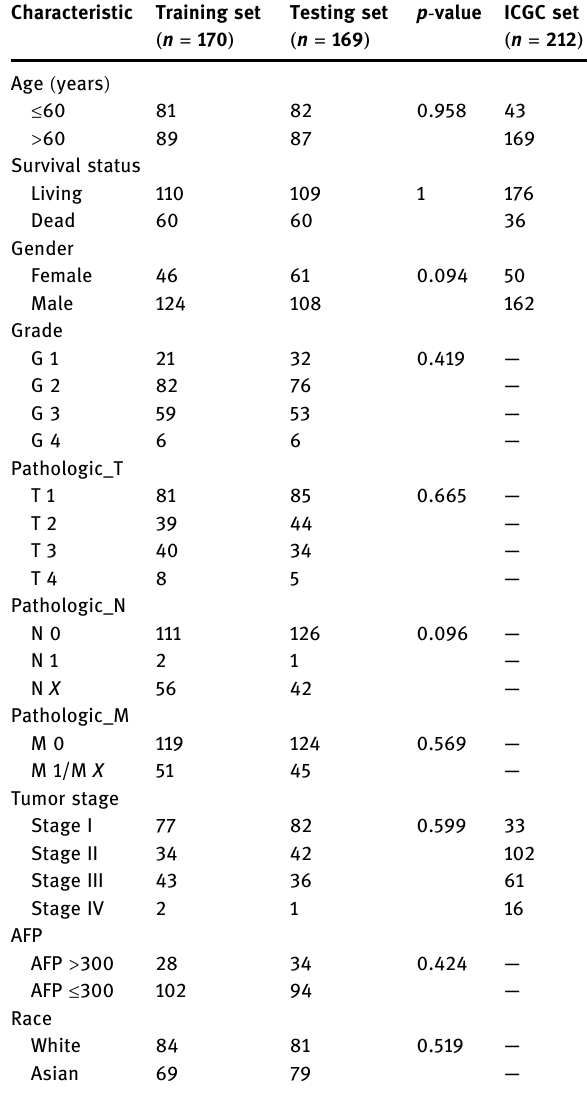
Table 1: TCGA and ICGC sample statistics Characteristic Training set ( n = 170